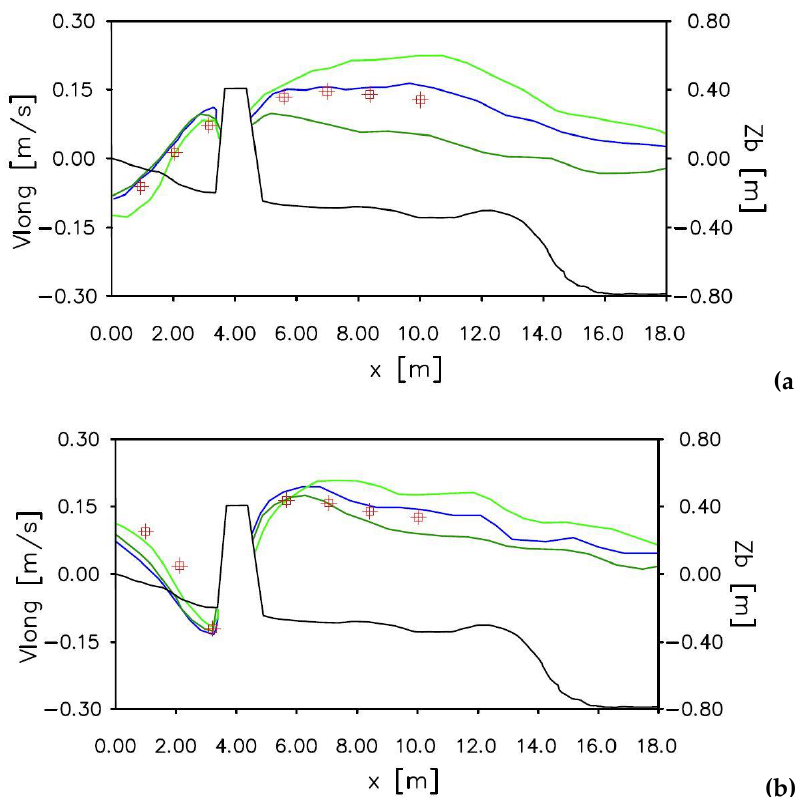
Figure 3. Long-shore currents: (a) at 𝑦 = 22 𝑚 , (b) at 𝑦 = 26 𝑚 . Comparison between experimental 298 data by Gravens and Wang [22] (red square) and numerical results of the depth-averaged longshore 299 currents (blue line). Numerical results of longshore currents near the bottom at a relative distance 300 from the free surface 𝑧/𝑧 𝑏 = 0.894 (light green line) and long-shore currents, near the free surface at 301 a relative distance from the free surface 𝑧/𝑧 𝑏 = 0.081 (green line). Bottom profile in black. 302 In Figure 4 the comparison between the experimental measurements obtained by [22] and the 303 numerical results in terms of cross-shore currents are shown in two different sections 𝑦 = 22 𝑚 and 304 𝑦 = 26 𝑚 . The blue lines, in Figures 4(a) and 4(b), show the depth-averaged cross-shore velocity 305 compared with the experimental measurements (red square). The green lines show the velocity 306 measured at two different position from the free surface, near the bottom 𝑧/𝑧 𝑏 = 0.894 (light green 307 line) and near the free surface 𝑧/𝑧 𝑏 = 0.081 (green line). 308